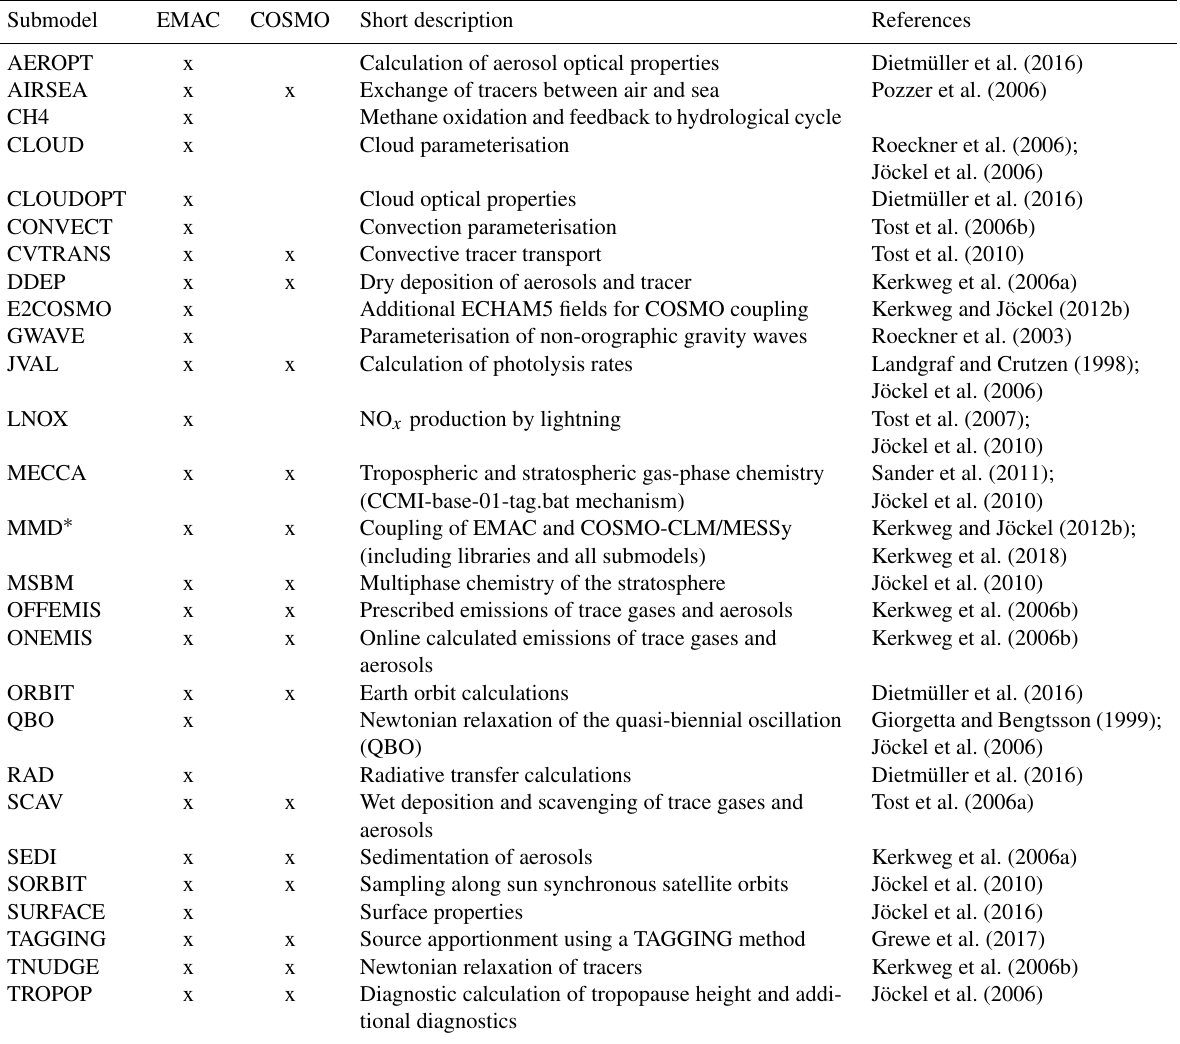
Table 1. Overview of the submodels applied in EMAC and COSMO-CLM/MESSy, respectively. Both COSMO-CLM/MESSy instances use the same set of submodels. MMD ∗ comprises the MMD2WAY submodel and the MMD